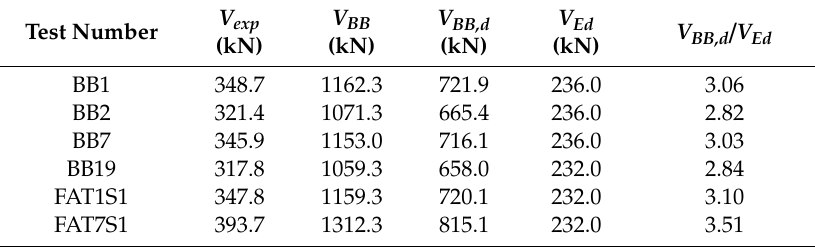
Table 6. Determination of the safety factor for the deck of Van Brienenoord